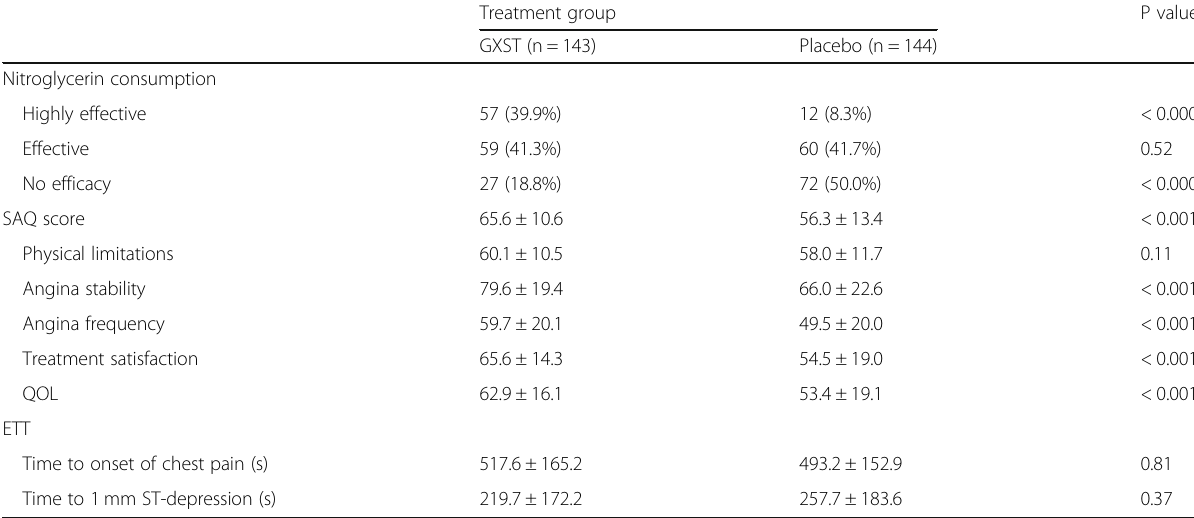
Table 3 Secondary efficacy evaluation